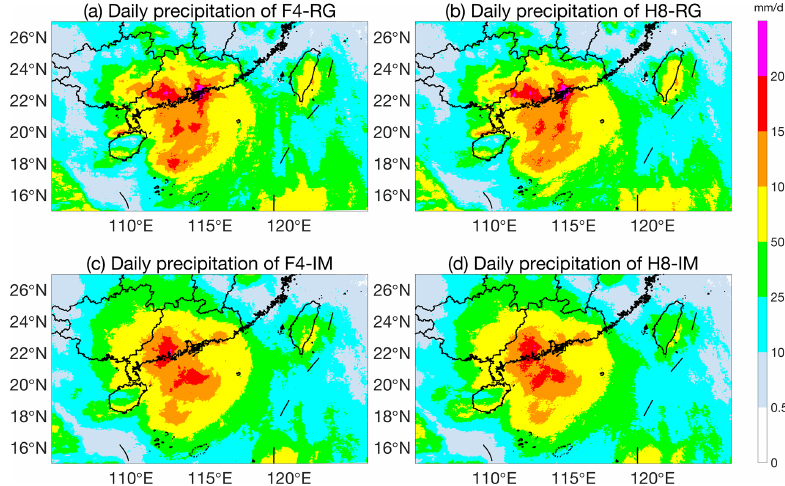
Figure 9. Comparison of daily precipitation among F4-RG, H8-RG, F4-IM and H8-IM on 16 September 2018.